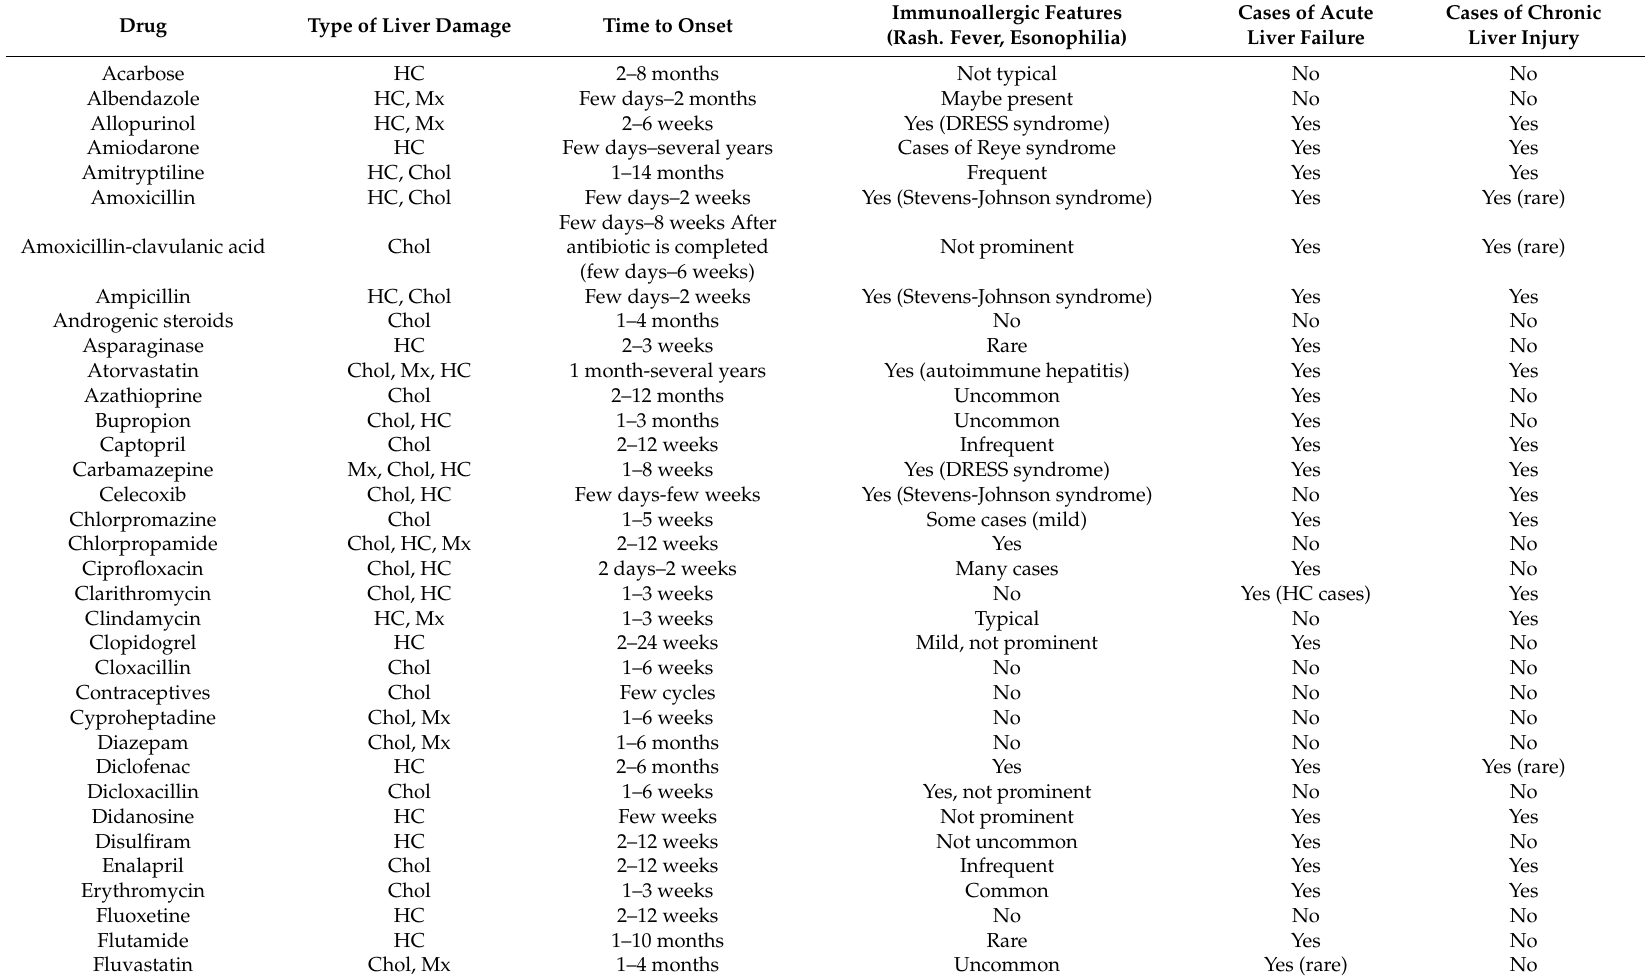
Table 3. Drugs and compounds predominantly associated with hepatocellular, cholestatic or mixed damage. (HC: Hepatocellular, Chol: Cholestatic, Mx: Mixed).